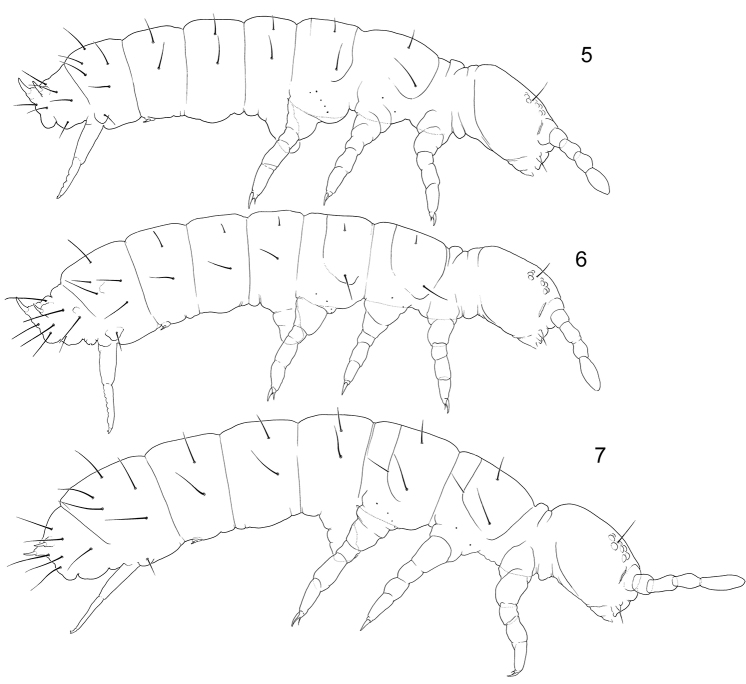
Appearance and macrochaetotaxy of Tetracanthella ‘sylvatica’ group 5T.sylvatica6T.annulata sp. nov. 7T.manschurica.